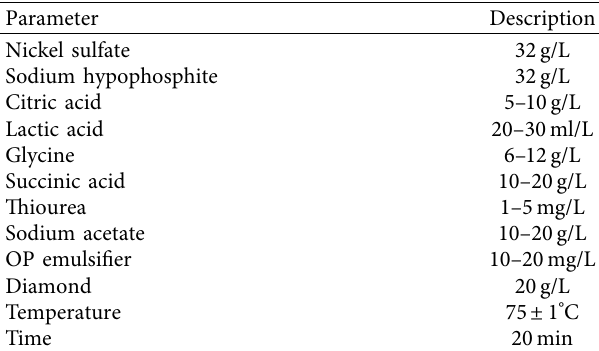
Table 2: Ni coating solution.